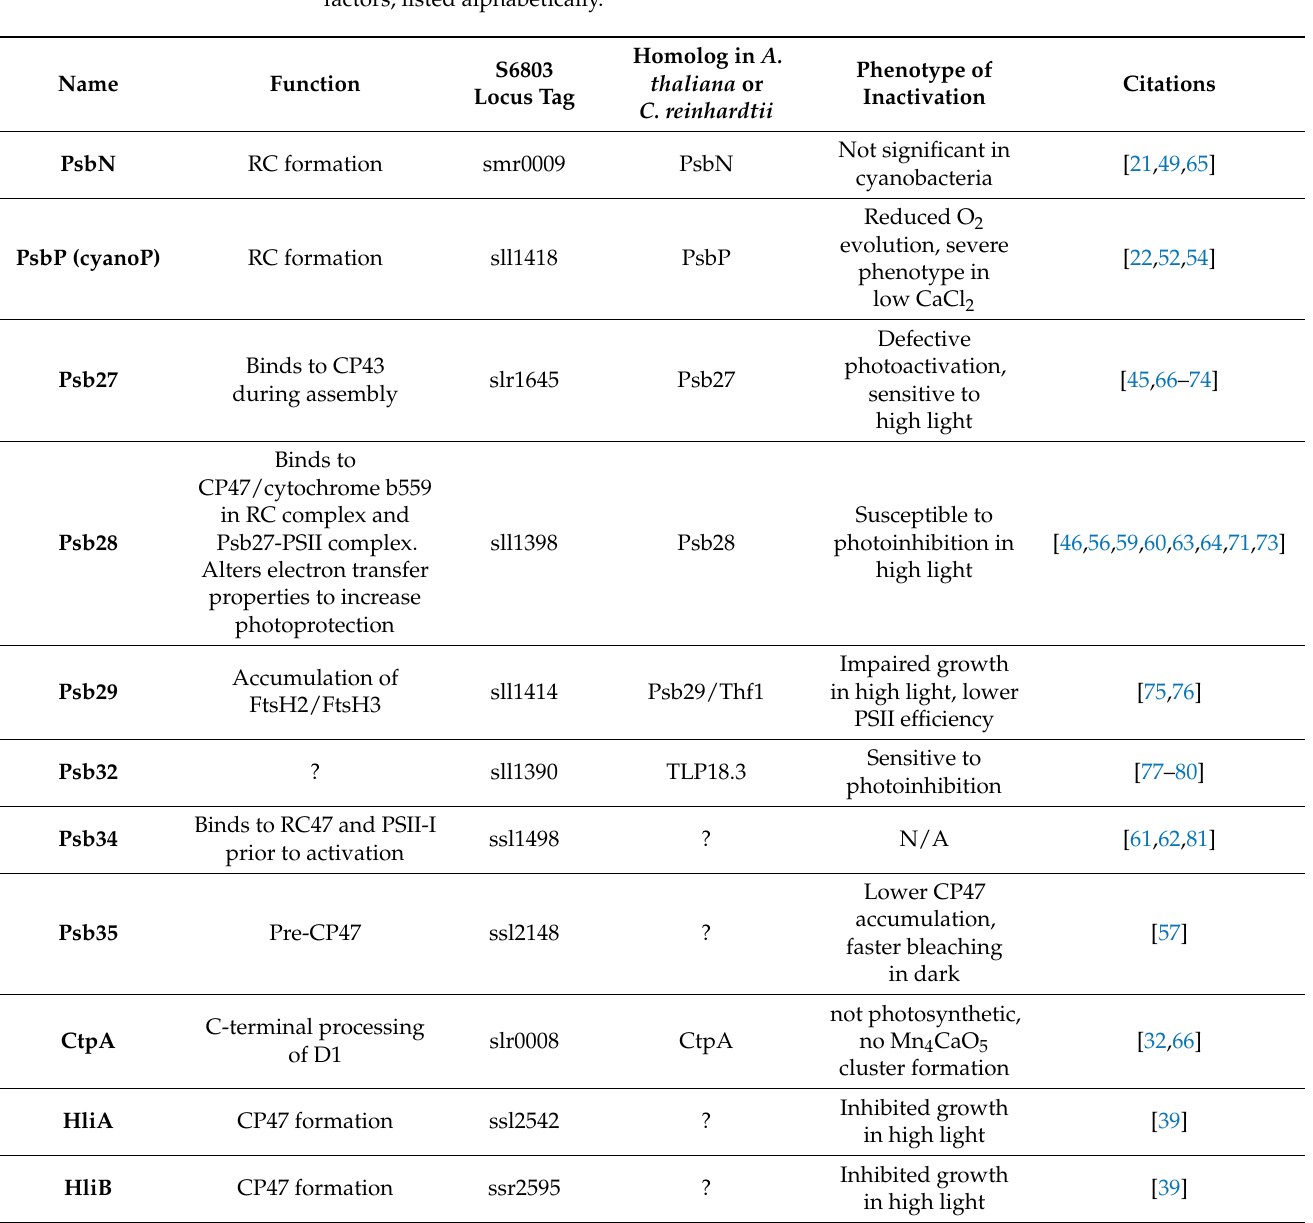
Table 1. PSII assembly factors. Psb subunits are listed alphabetically, followed by additional assembly factors, listed